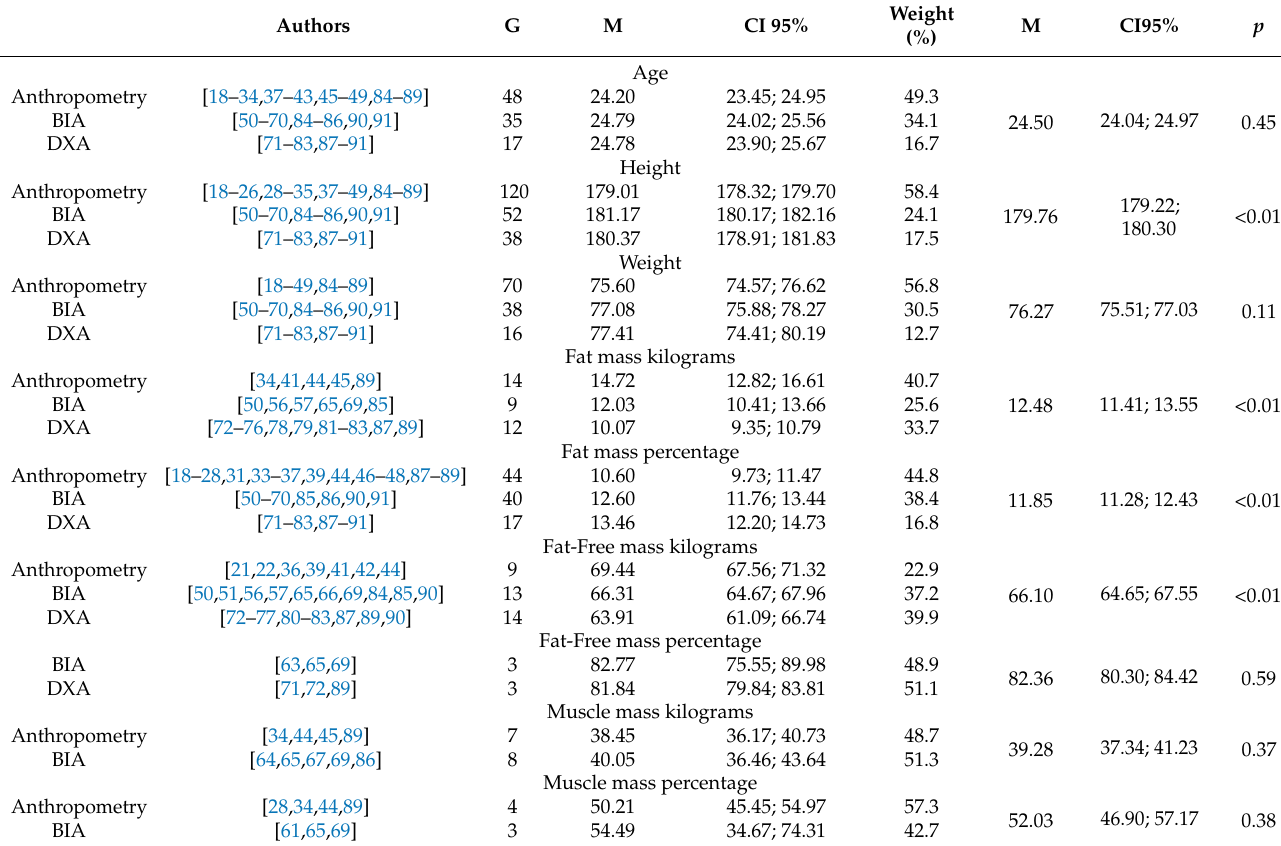
Table 6. Meta-analysis by groups according to the evaluation method used.